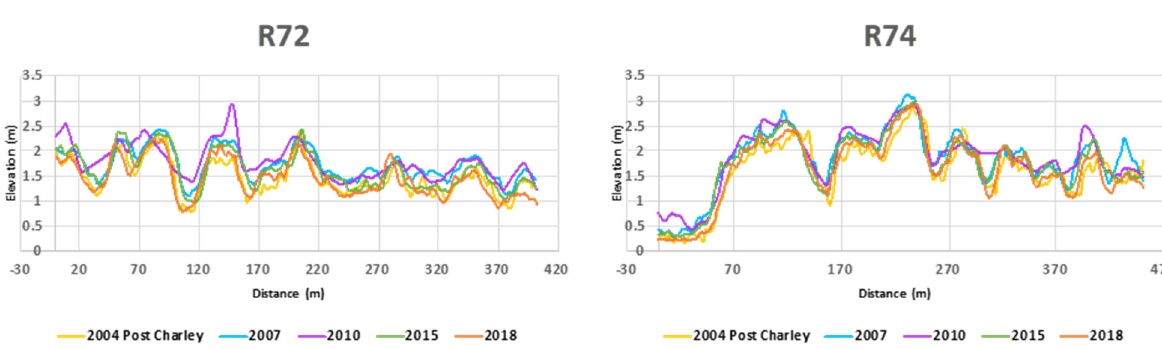
Figure 3. R67 and R79 elevation profiles with respect to NAVD88 of North Captiva Island for 2004 post-Charley through 2018.